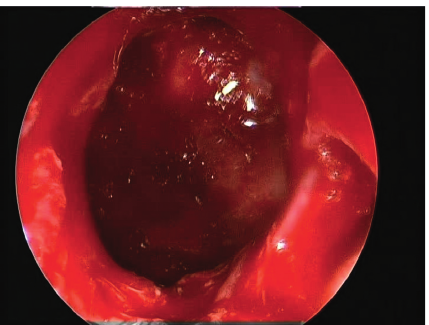
Figure 12: Postoperative endoscopic view showing a wide clean sphenoid